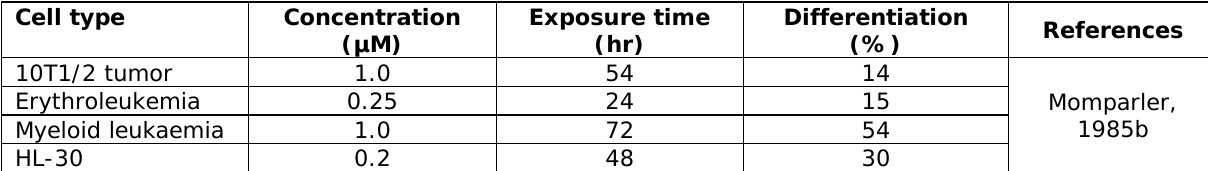
Table 2: Decitabine induction of differentiation in murine and human leukaemia cell lines Cell